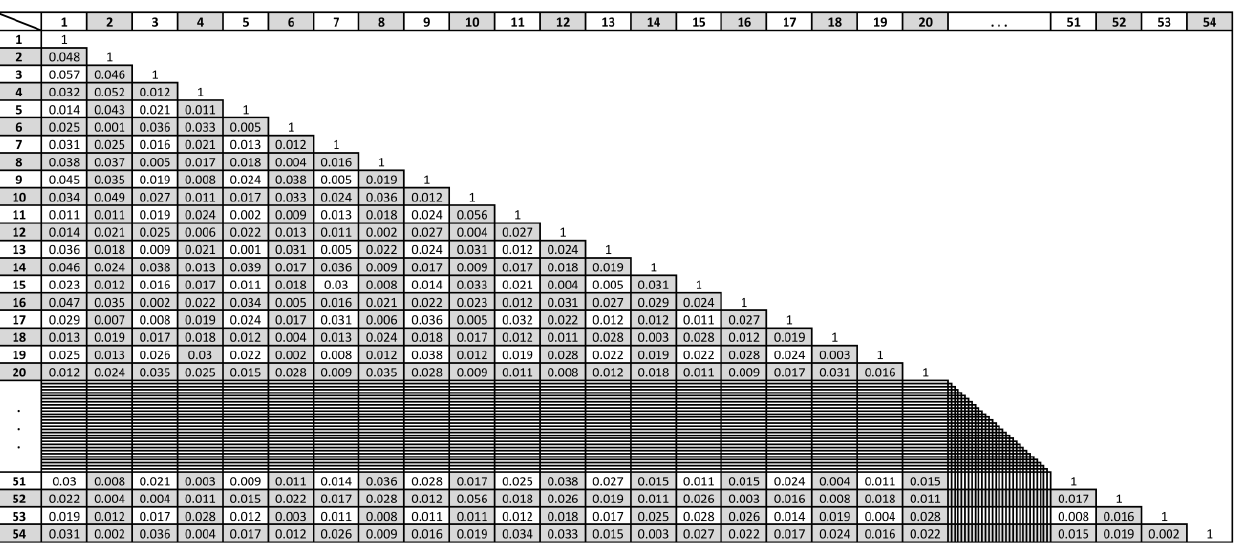
Figure 2. Measurement of the interdependency of 54 factors.